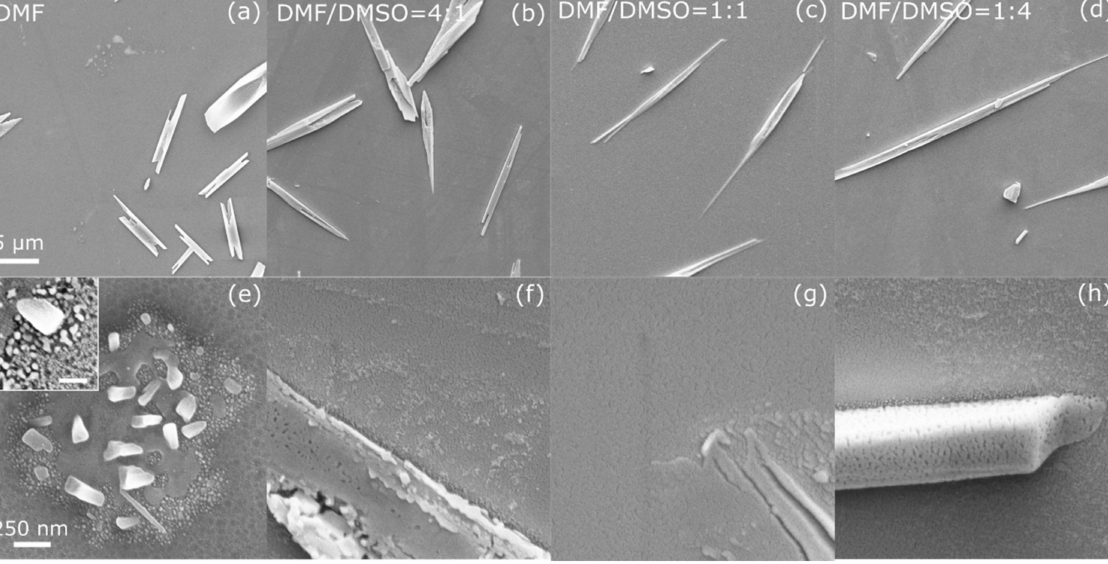
Figure 10. Scanning electron micrographs of annealed (PRSH)PbI 3 films prepared in DMF and in DMF/DMSO mixtures, taken at low ( a – d ) and high ( e – h ) magnification. The scale bars in the left panels apply to all micrographs. The inset in ( e ) shows a high magnification micrograph of the film in ( a ) (the scale bar corresponds to 100